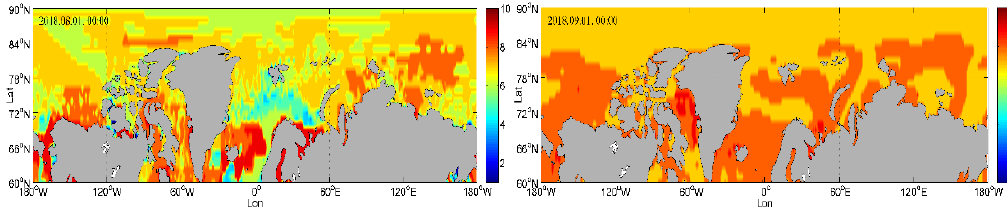
Figure 11. The spatial variability of visibility at 00:00 on August 1, 2018 and 00:00 on September 1, 2018.